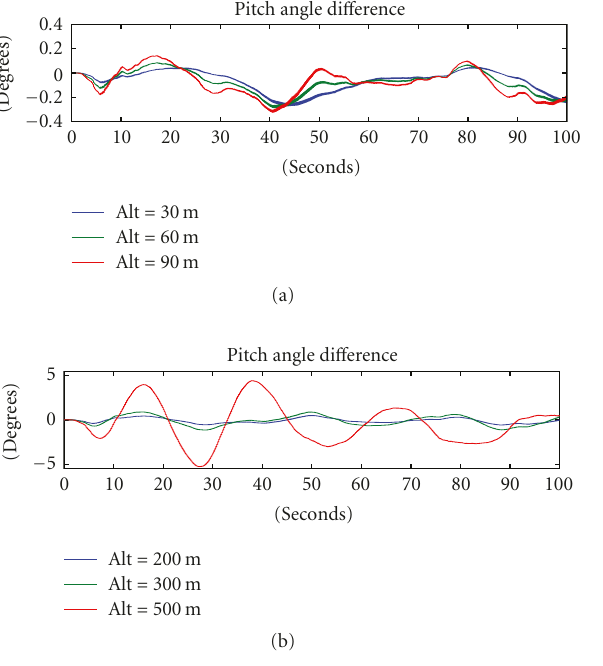
Figure 8: Di ff erence between the roll angle estimated by the KF with a constant position update and the KF updated using odometry position. It can be noticed how the increasing of the flight altitude makes the oscillatory behavior of the system more evident with an increasing in